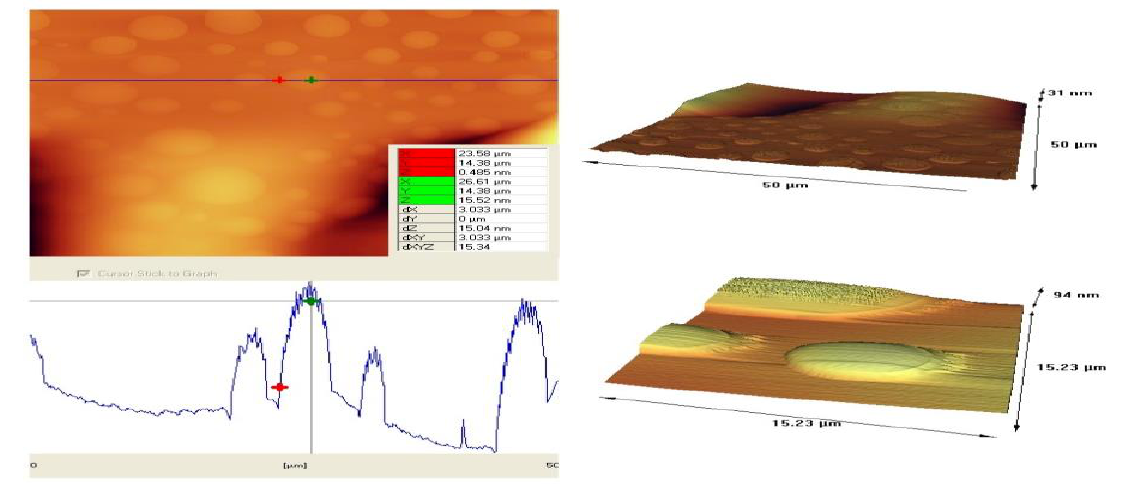
Fig. 3. AFM images of dendrimer